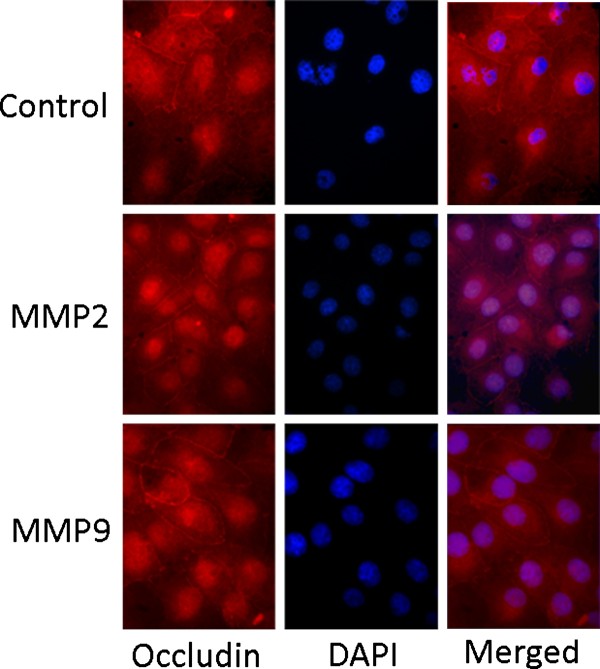
Immunofluorescent microcopy of pleural mesothelial cells treated or not with MMP2 and MMP9 using an anti-occludin antibody. Both control cells and cells treated with MMP2 or MMP9 displayed a continuous staining at cell periphery. Nuclei were stained with Dapi.